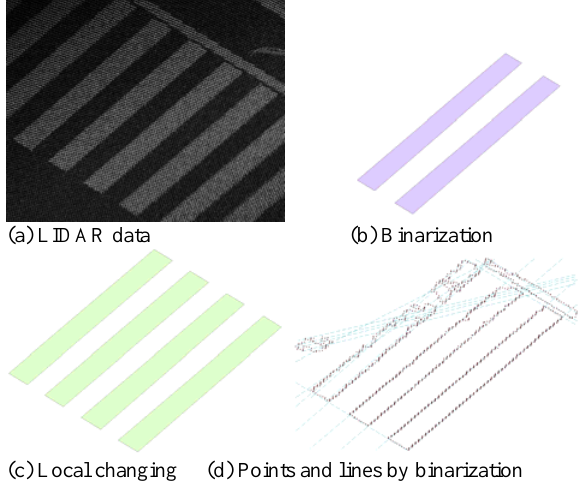
Bus stop : This traffic marking means “bus stop”.